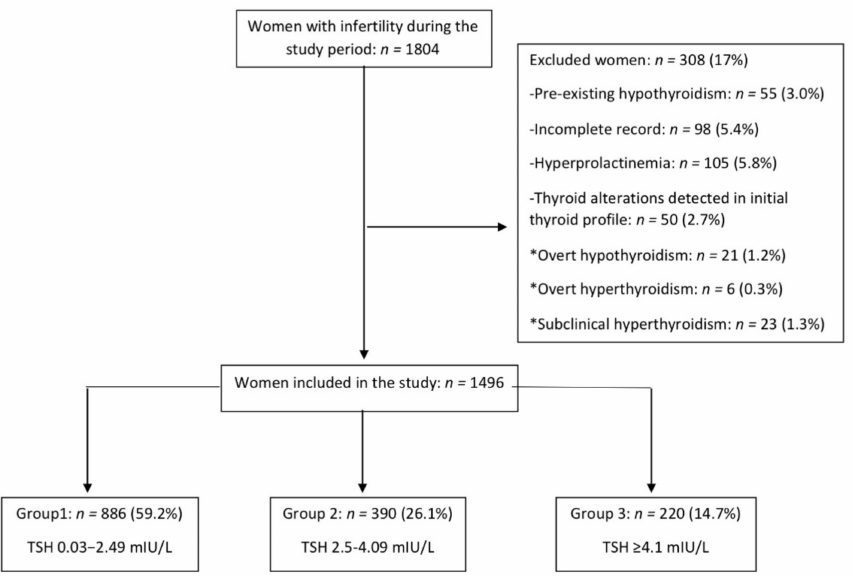
Figure 1. Flow-chart of participants and prevalence of SCH and other thyroid alterations among infertile Mexican